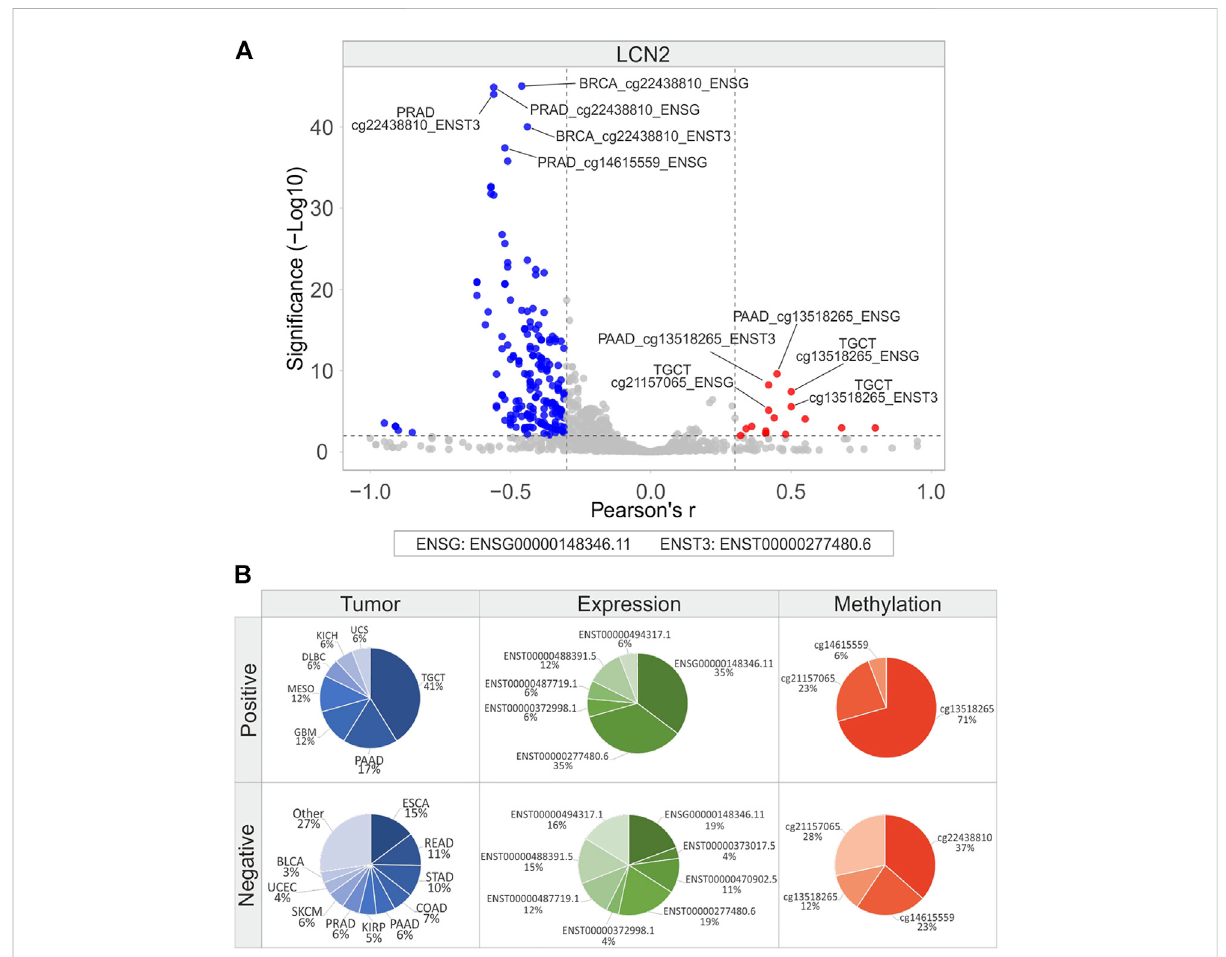
FIGURE 10 Correlationanalysisbetween LCN2 gene/isoformsexpressionandrelativeCGprobesetsmethylationlevelsineachtumortype. (A) Volcanoplot showing the correlation between CG probesets and gene/isoforms expression of LCN2 (Pearson ’ s r ≥ 0.3 and ≤ − 0.3, p ≤ 0.01). The top ten hits ( fi ve positiveand fi venegative)basedoncorrelationsigni fi cancearelabeled.Bluedots:negativecorrelation,reddots:positivecorrelation. (B) Percentage oftumortypes,gene/isoformsandCGprobesetsshowingPearson ’ sr ≥ 0.3and ≤ − 0.3( p ≤ 0.01),separately.Nomorethantenvariableswiththe highest correlation values are